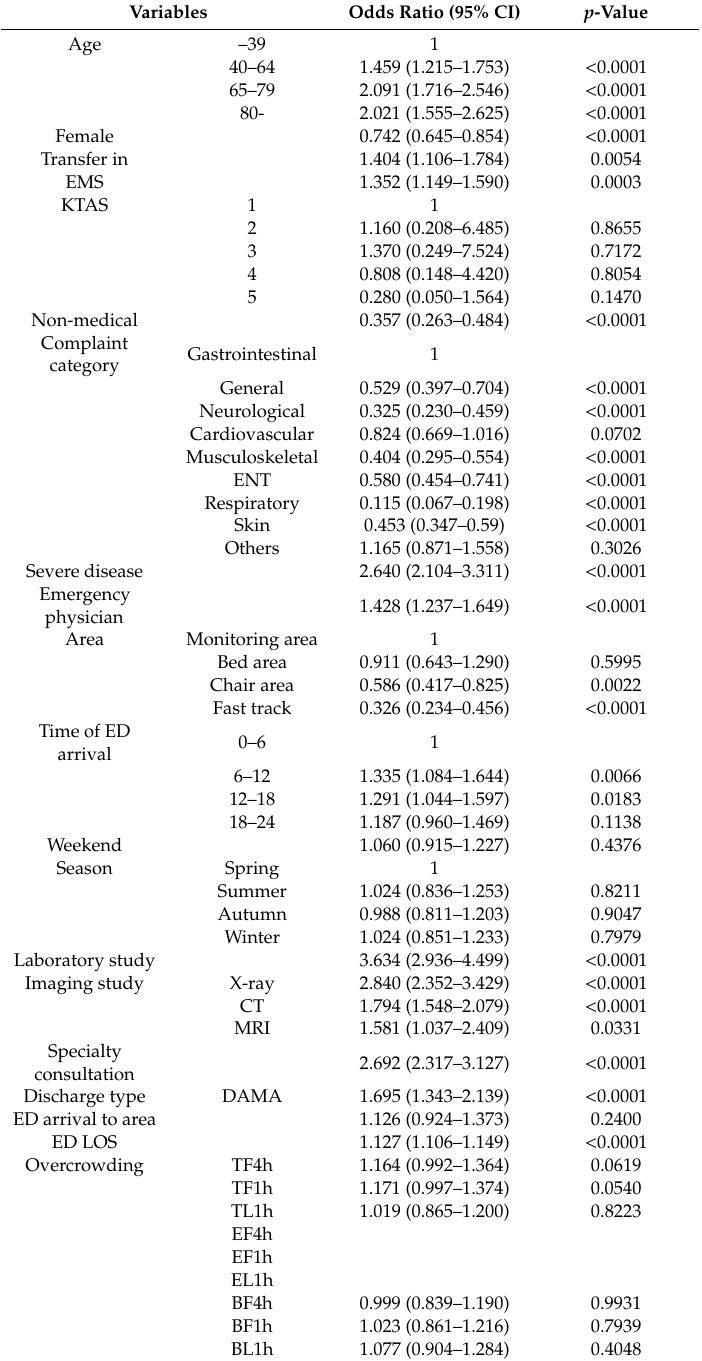
Table A5. Univariable logistic regression of emergency department overcrowding for return visit with